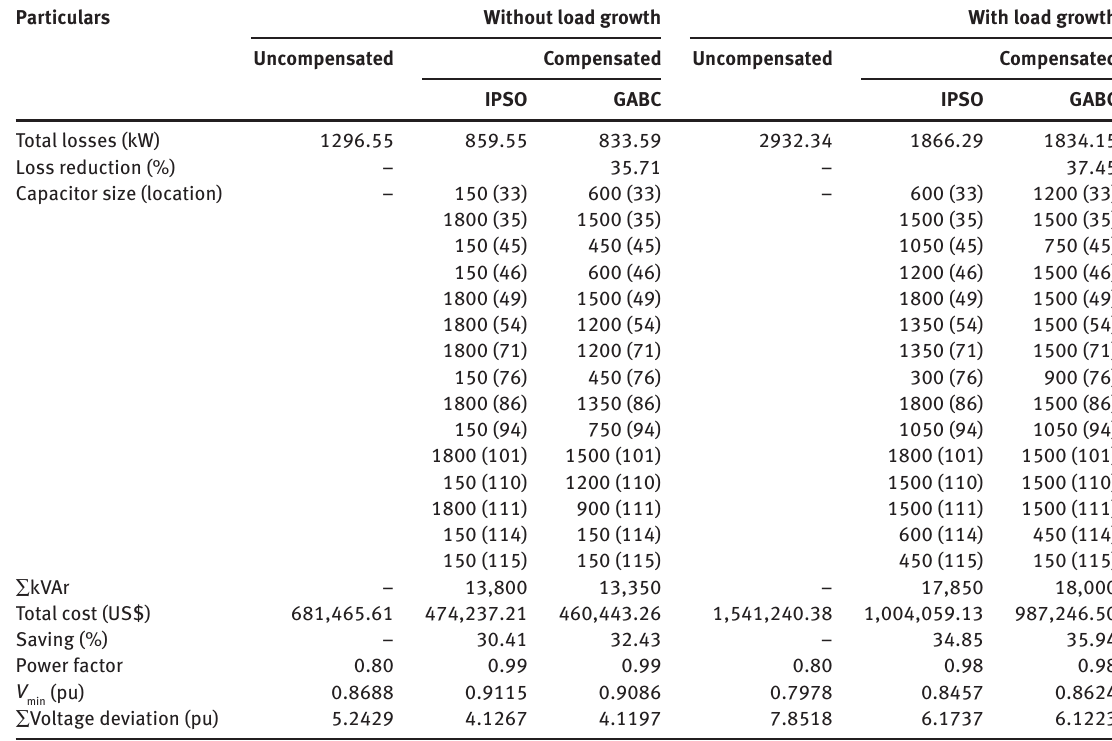
Table 14: Simulation Results of the 118-Bus Distribution Network after SC Placement Using the LSF Approach.